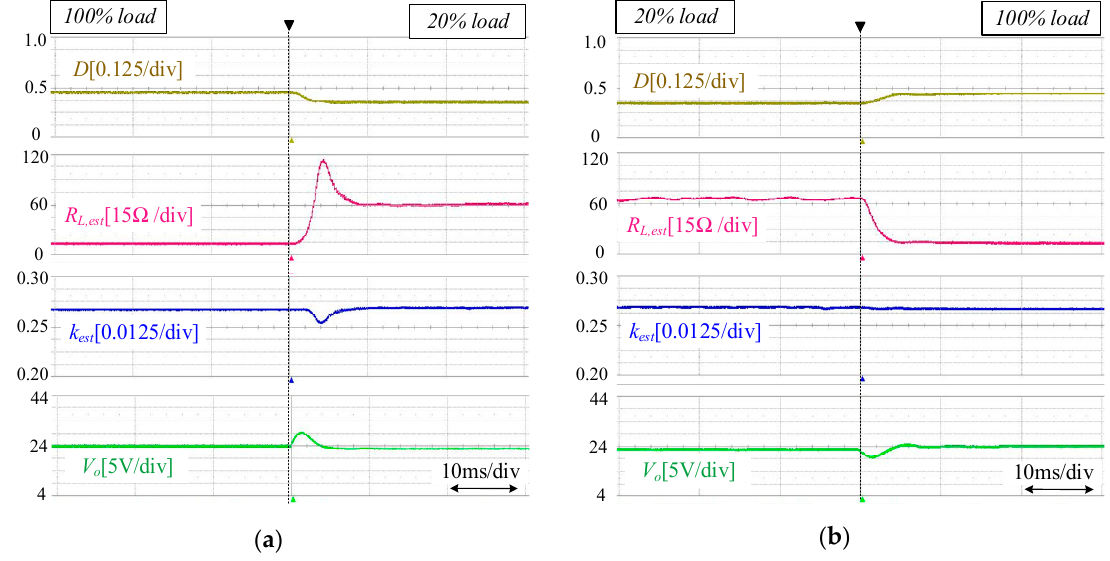
Figure 10. Waveforms of the switching duty cycle ( D ), estimated resistance ( R L,est ), estimated coupling coefficient ( k est ), and output voltage ( V o ) where k = 0.266. A step load is applied from ( a ) 100% to 20% and ( b ) 20% to 100%.